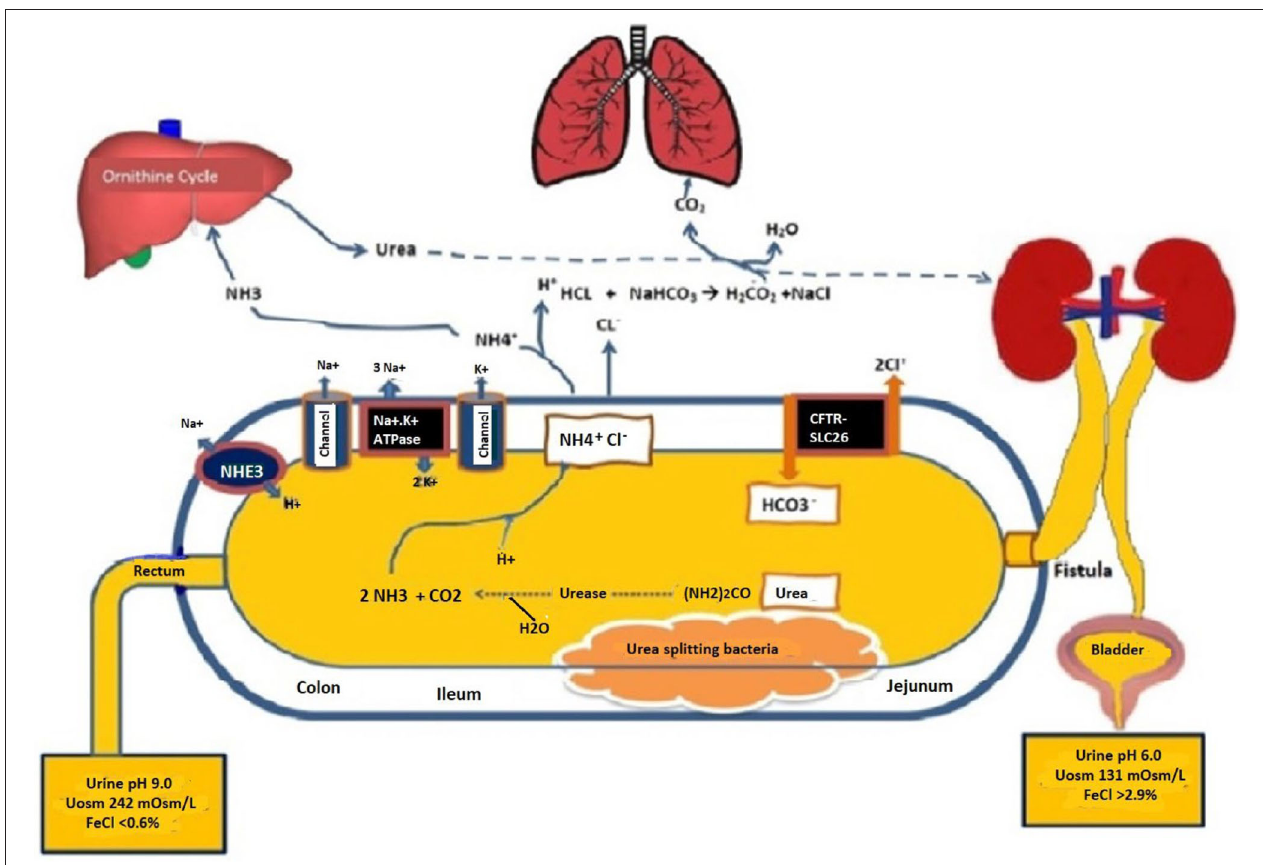
FIGURE 3 | Schematic of the uroenteric fistula with differential urine pH and solutes from the bladder and bowel urines taken concurrently when in metabolic balance maintained by parenteral buffer therapy at 10–12 mmol/kg/day as sodium/ potassium acetate. H 2 O, Water; HCO 3 , Bicarbonate; NaCl, Sodium chloride; (NH 2 ) 2 CO, Urea; NH 3, ammonia; CO 2 , carbon dioxide; NH 4 Cl, ammonium chloride; CFTR-SLC26, Cystic fibrosis-chloride transporter-soluble carrier family 26; Na-K ATPase, Sodium-potassium adenosine triphosphatase; NHE3, sodium-hydrogen exchanger 3; Uosm, urine osmolarity; FeCl, Fractional excretion of